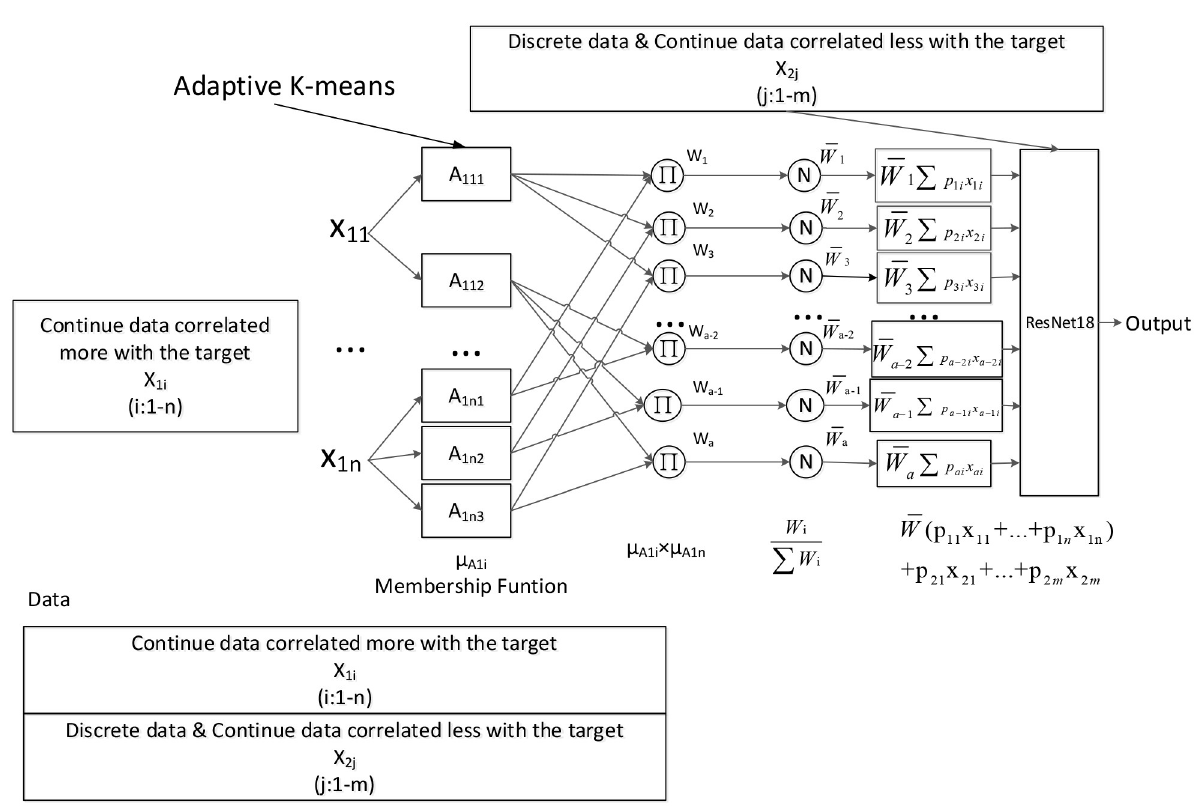
Fig 8. The architecture of the proposed